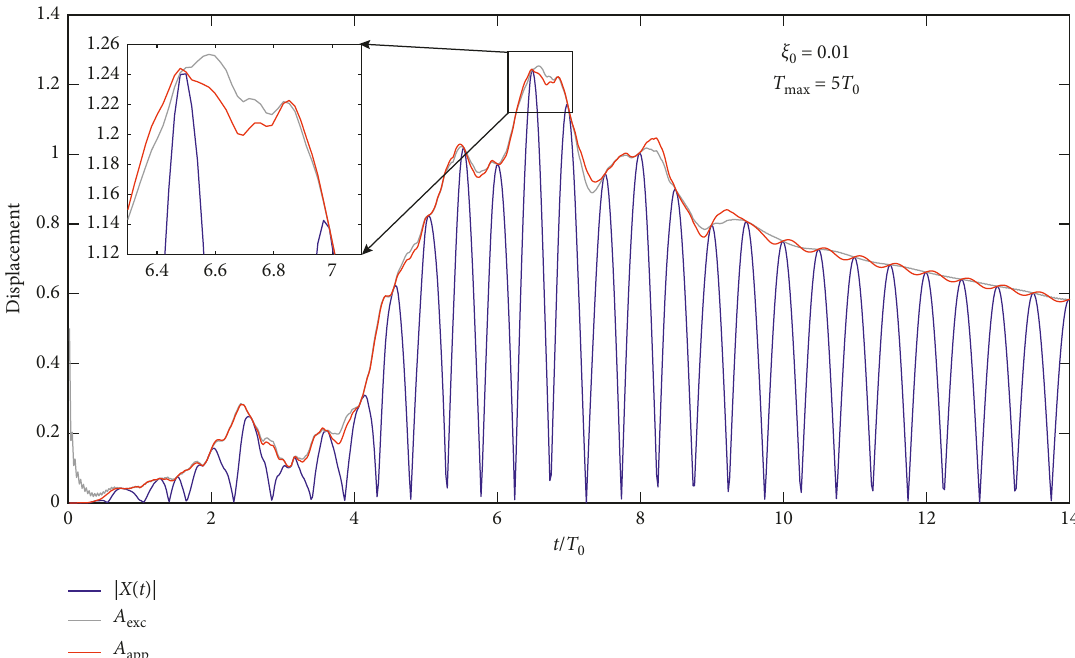
Figure 3: Structural displacement X